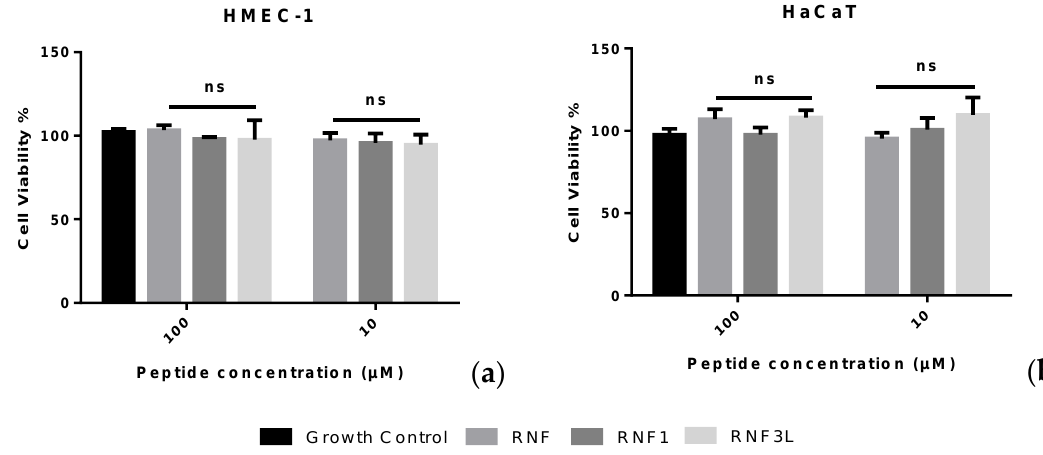
Figure 6. The cytotoxicity of (RNF) RNF1 and RNF3L: on HMEC-1 cells ( a ); and on HaCaT cells ( b ).